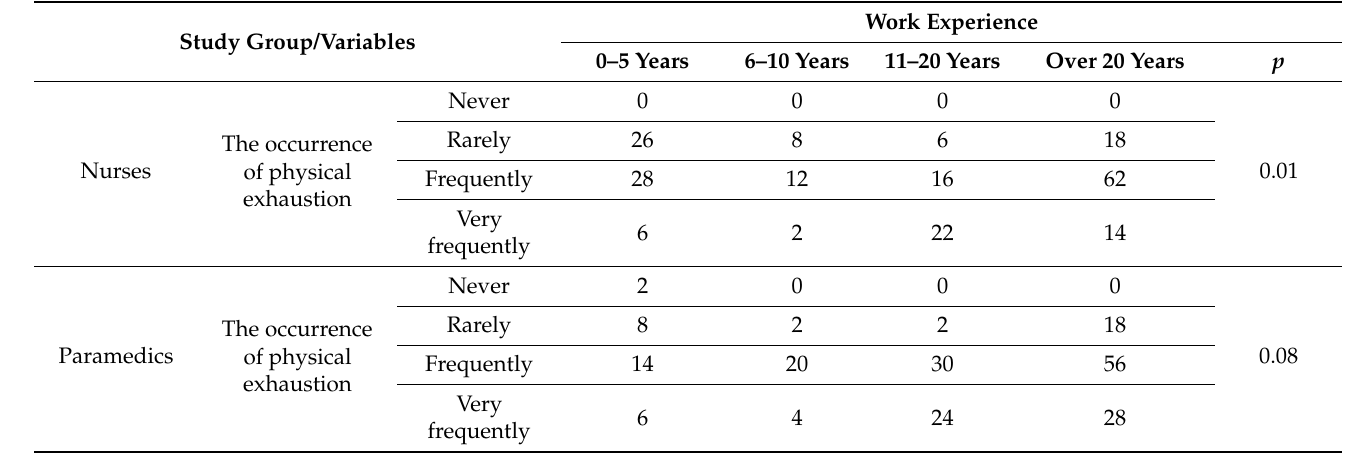
Table 9. The relationship between the length of work experience and physical exhaustion in nurses and paramedics.